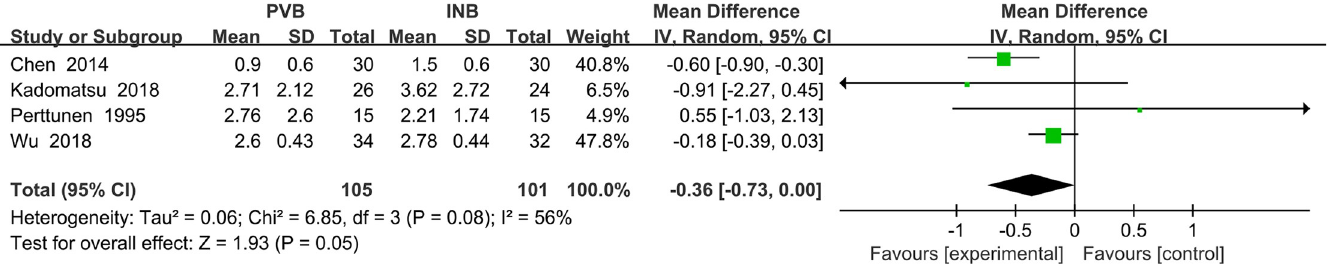
Fig 9. Forest plot of comparison: PVB VS INB. Outcome: VAS at rest at the first 24 h.